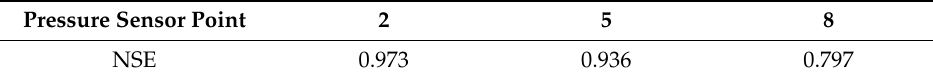
Table 2. Nash-Sutcliffe efficiency (NSE) in pressure sensor points.